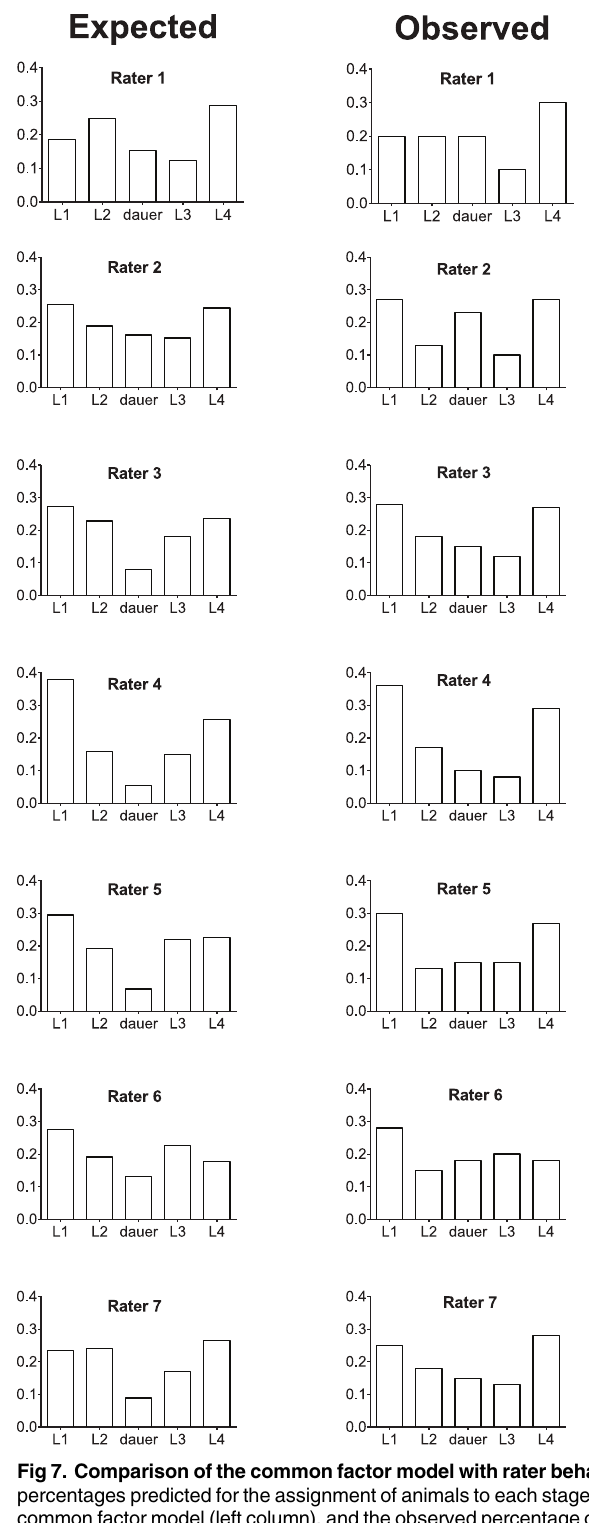
Fig 7. Comparison of the common factor model with rater behavior. Shown are bar-graphs depicting the percentages predicted for the assignment of animals to each stage by individual reviewers from the estimated common factor model (left column), and the observed percentage of animals assigned to each of the developmental stages for the raters (right column).